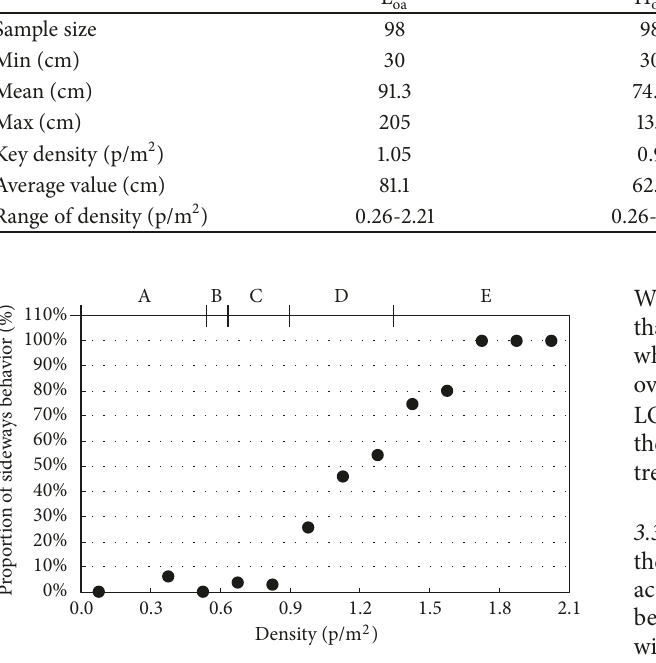
Figure 9: Proportion of sideways pedestrian overtaking behavior with the increase of